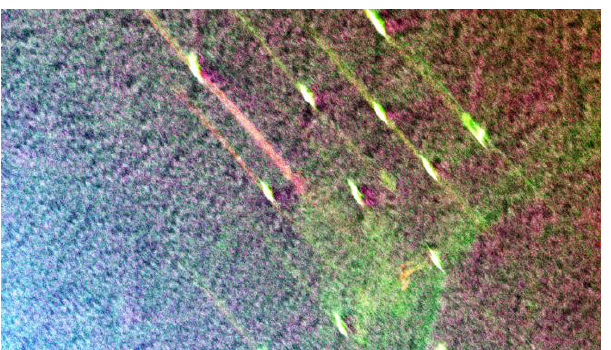
Fig. 10 UAVSAR Input Image